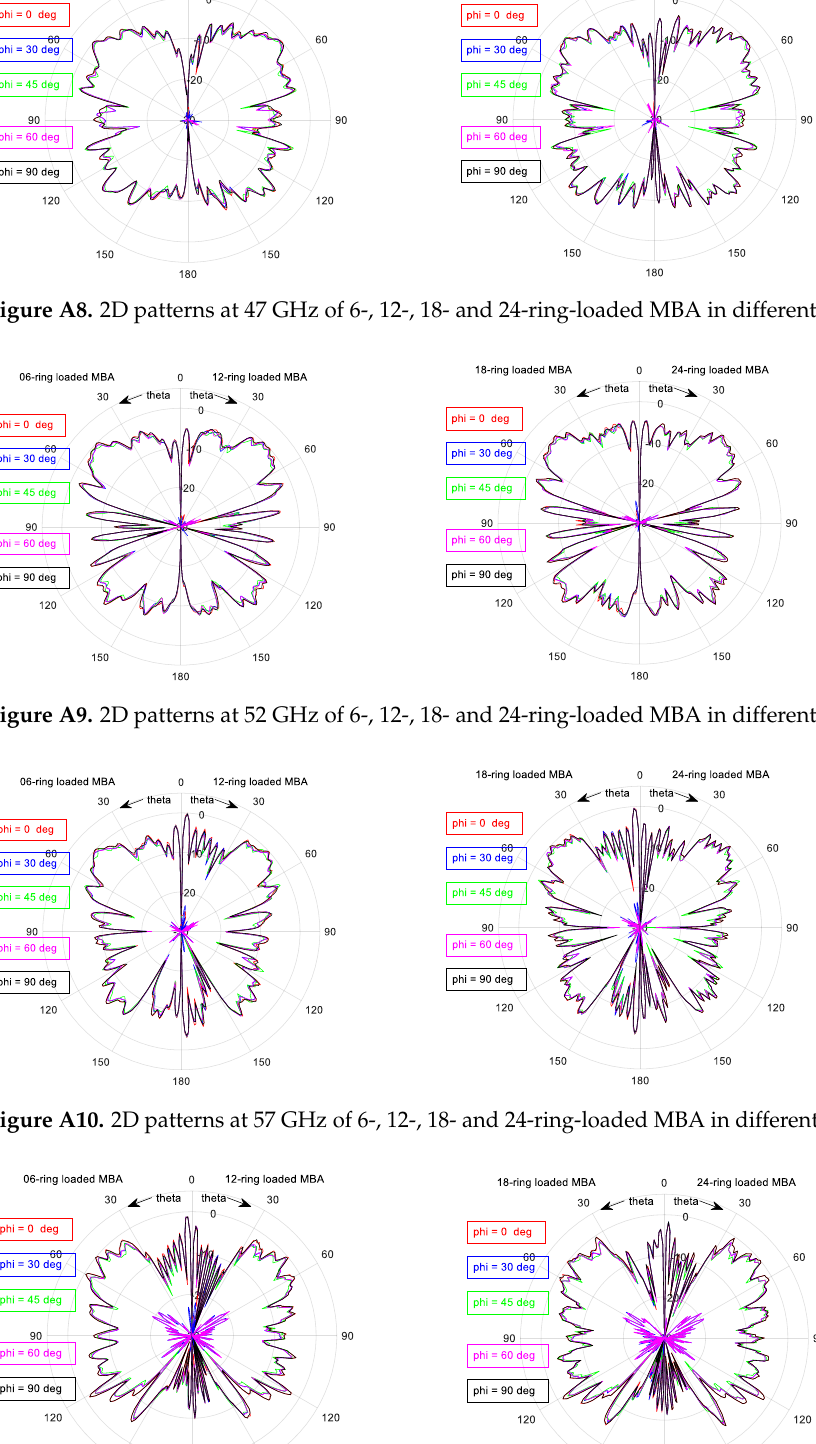
Figure A7. 2D patterns at 37 GHz of 6-, 12-, 18- and 24-ring-loaded MBA in different cutting planes.